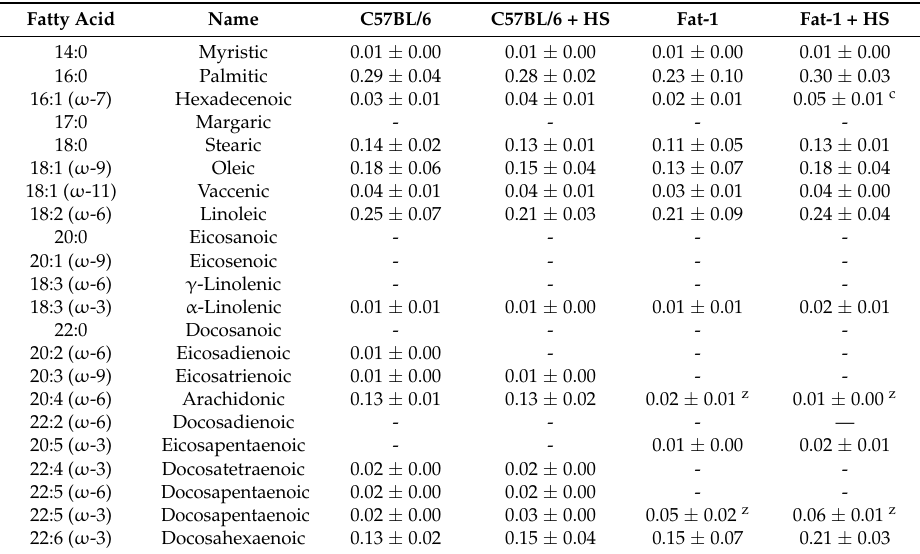
Table 2. Composition of fatty acids in the gastrocnemius muscle (g/100 g wet